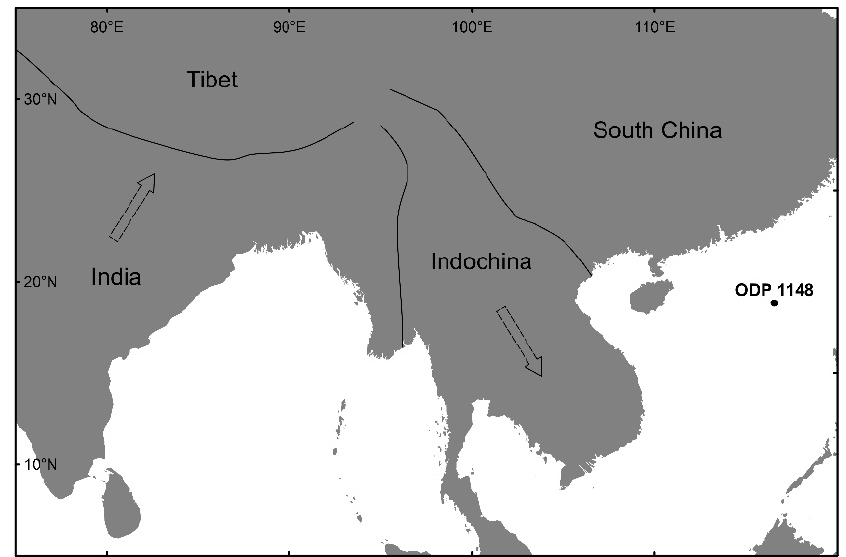
Figure 6. Simplified map showing the triggering mechanism of the Baiyun–Liwan submarine slide.